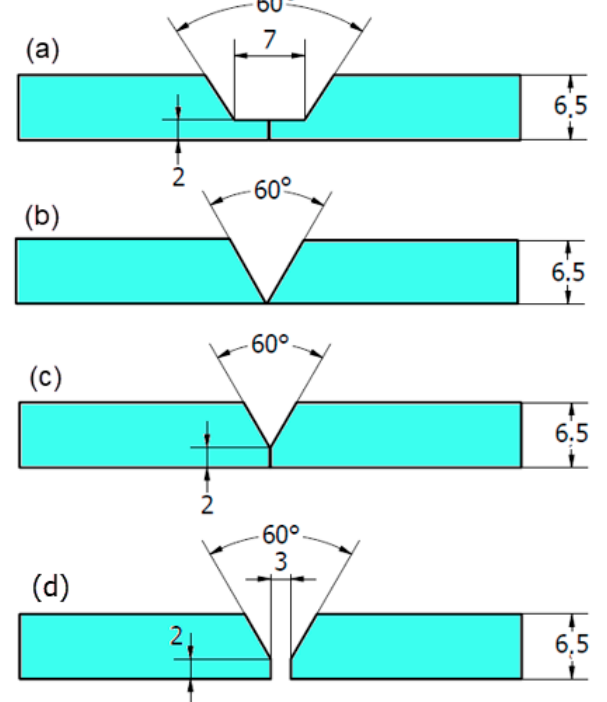
Figure 1. Groove joint designs ( a – c ) for the FSW process and ( d ) for the GTAW process [33]. The FSW tool was designed with a tapered pin geometry. The shoulder diameters, pin tapered angle, pin tip, and pin length were selected as 20 mm, 30°, 5 mm, and 5.5 mm, respectively. Due to the high frictional stress and heating during FSW of DSS; tool, shoul- der, and pin were fabricated from tungsten carbide (WC) [1]. Figure 2 (a) shows the draw- ings of the WC tool.